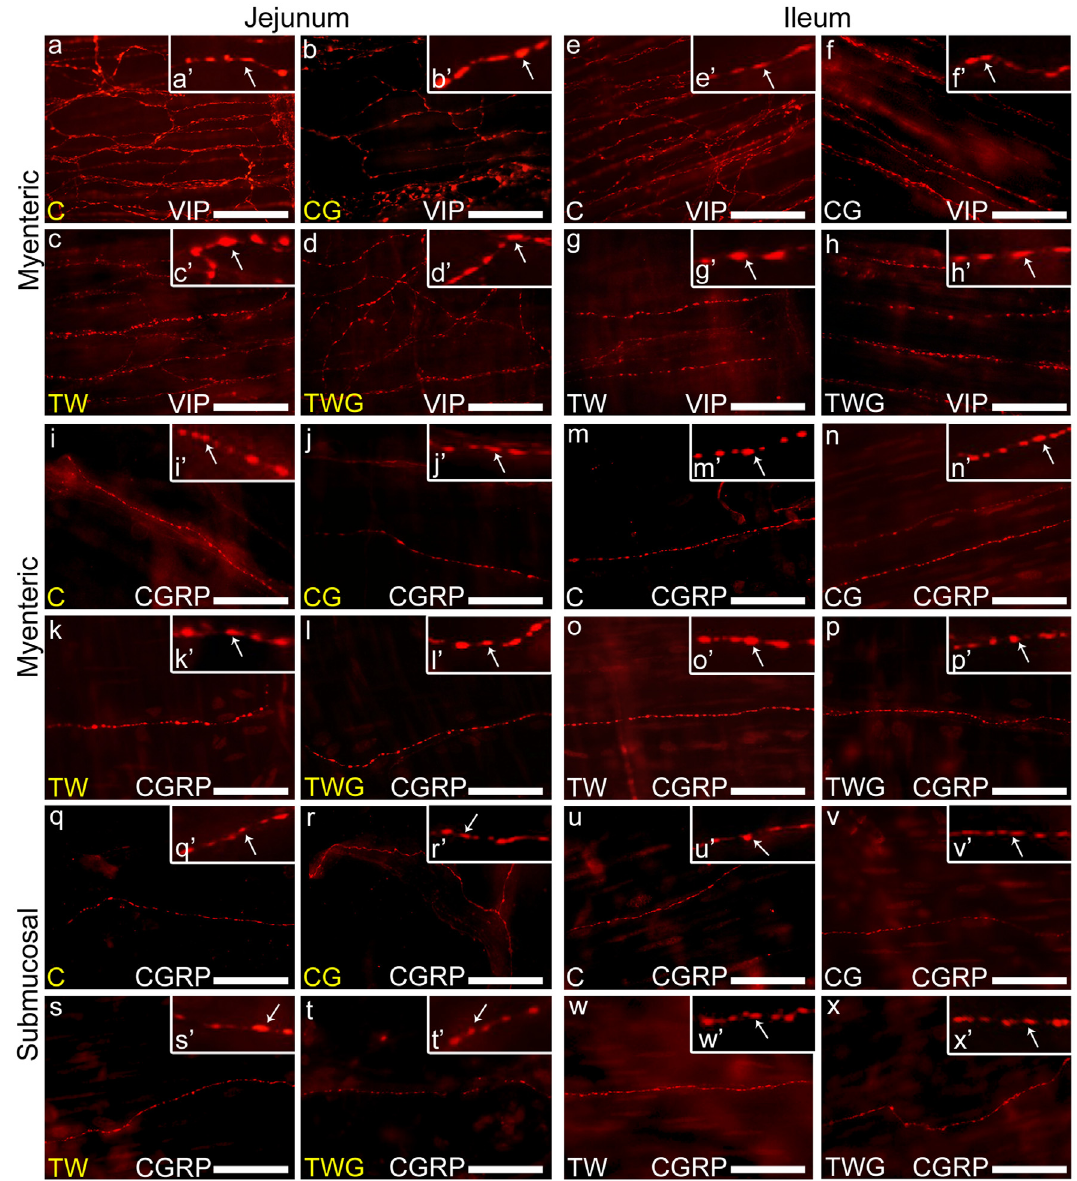
Fig 3. Representative images of the myenteric varicosities nerve fibers. Myenteric VIP-IR and CGRP-IR varicosities of the jejunum: (a-d) VIP-IR nerve fiber and (i-l) CGRP-IR nerve fiber. Ileum: (e-h) VIP-IR nerve fiber and (m-p) CGRP-IR nerve fiber. Experimental groups: control (C); control supplemented with 2% L-glutamine (CG); Walker-256 tumor (TW); and Walker-256 tumor supplemented with 2% L-glutamine (TWG). (q-x) representative images of the submucous CGRP-IR varicosities nerve fibers of the jejunum (q-t) and ileum (u-x) from experimental groups (C, CG, TW and TWG). All enlarge images on the top right of each image with white arrows indicate examples of immunoreactive varicosity (a'-x'). Scale Bar 25 μ